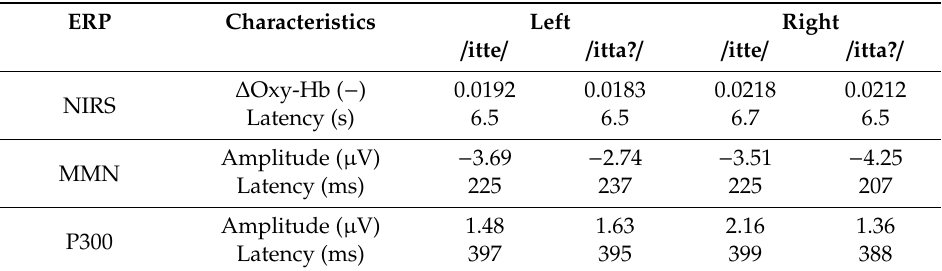
Table 2. The peak of the concentrations, MMN, and P300 in grand mean waves.